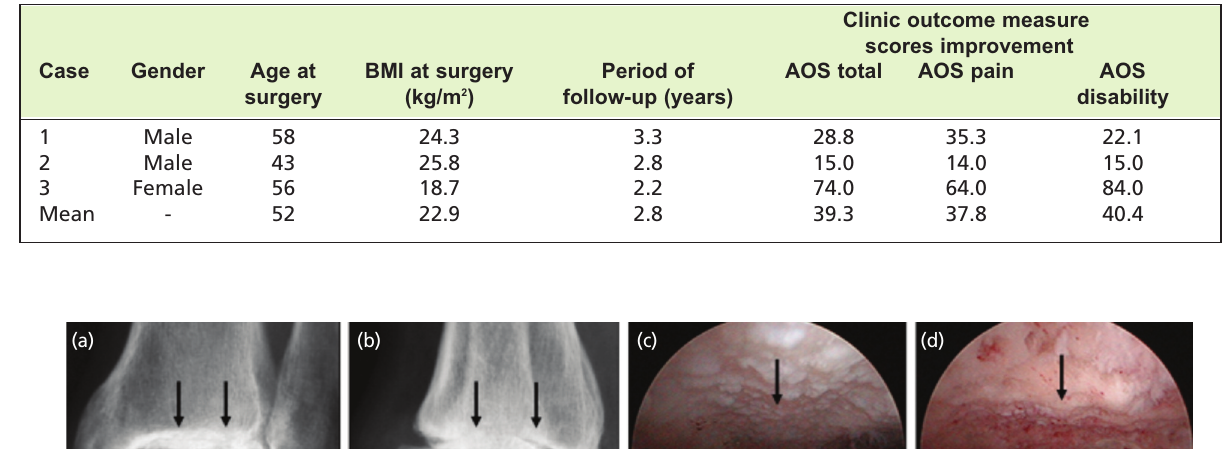
Patient demographics and improvement in clinical outcome measure scores from baseline to final follow-up in all Table I: